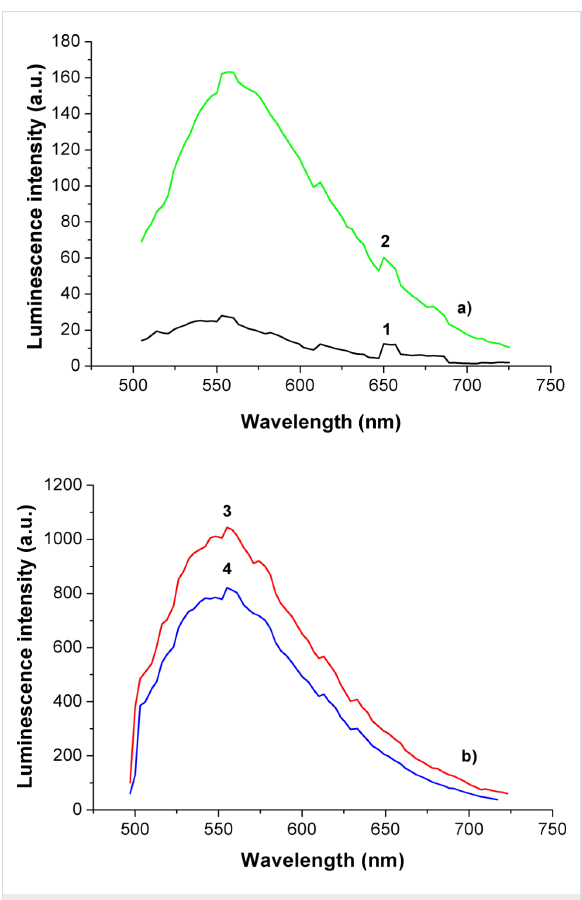
Figure 4: Spectra of luminescence excited at 488 nm. a) Initial powder mixture of Er/Yb chlorides (1), Er/Yb oxides powder, obtained with SiO 2 NPs (2); b) oxide particles in glycerin, in the presence of SiO 2 NPs (3) and without SiO 2 NPs (4).